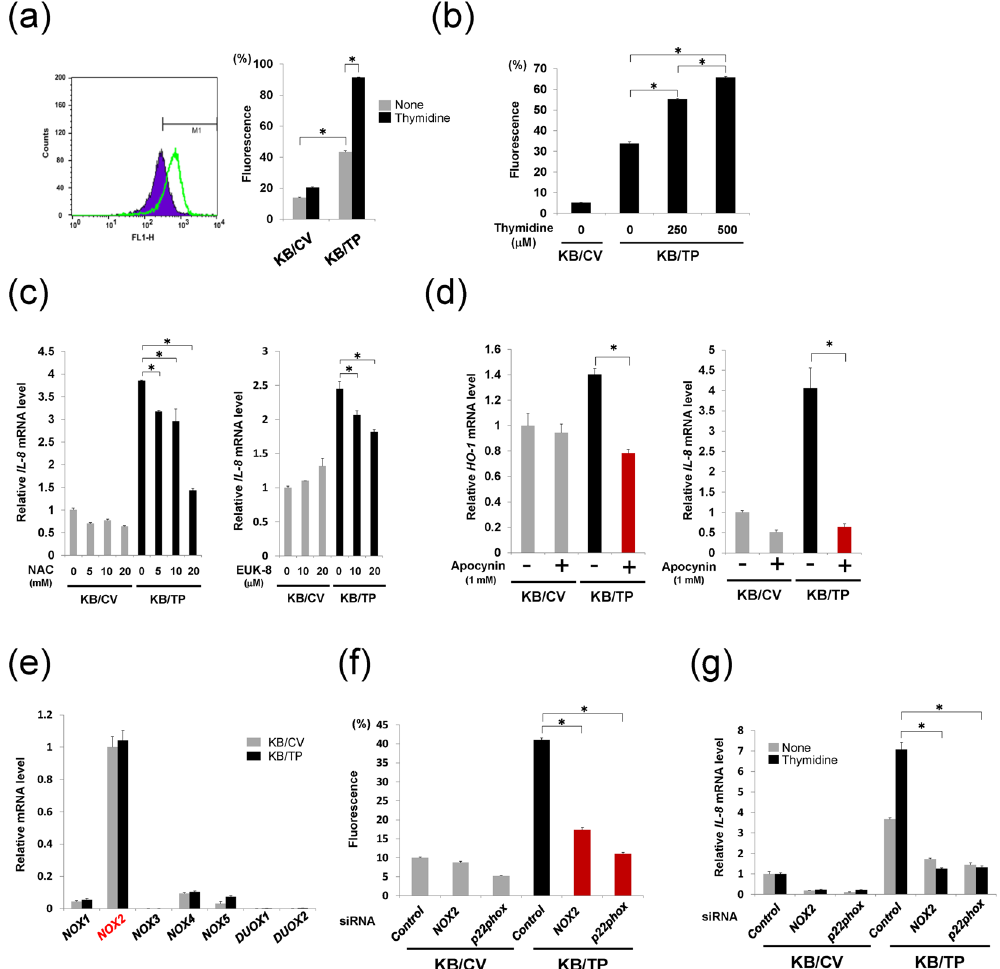
Figure 1. Involvement of NADPH oxidase in TP-induced ROS generation. ( a ) A representative sample for three independent FACS analyses is displayed (Left). Cells were treated with 500 μ M thymidine for 48 h, and then ROS levels were measured in the cells. Proportions of cells in the M1 fraction are shown as relative levels of ROS. Relative ROS levels in KB/CV and KB/TP cells in the absence or presence of 500 μ M thymidine are measured by using H 2 DCF-DA fluorescence dye (Right). ( b ) ROS levels in KB/CV and KB/TP cells incubated in the absence or presence of thymidine at 250 or 500 μ M for 48 h. ( c ) Attenuated expression of IL-8 mRNA in KB/ TP cells treated with NAC (left) and EUK8 (right) for 48 h. Expression of IL-8 in KB/CV and KB/TP cells was determined by real-time PCR. ( d ) Decreased expression of HO-1 and IL-8 mRNAs in KB/TP cells treated with apocynin for 48 h. ( e ) Expression of NOX isoforms in KB cells. Expression levels of NOX isoforms in KB/CV and KB/TP cells were determined by real-time PCR. ( f ) The effect of down-regulation of NOX2 and p22phox on the production of ROS in KB/CV and KB/TP cells. The cells transfected with NOX2 siRNA or p22phox siRNA were treated with 10 μ M H 2 DCF-DA for 1 h and ROS levels were determined by using FACScan. ( g ) KB cells transfected with NOX2 siRNA or p22phox siRNA were treated with or without 500 μ M thymidine for 48 h and IL-8 mRNA expression levels were determined by real-time PCR. Data are presented as mean ± SD. ∗ P <